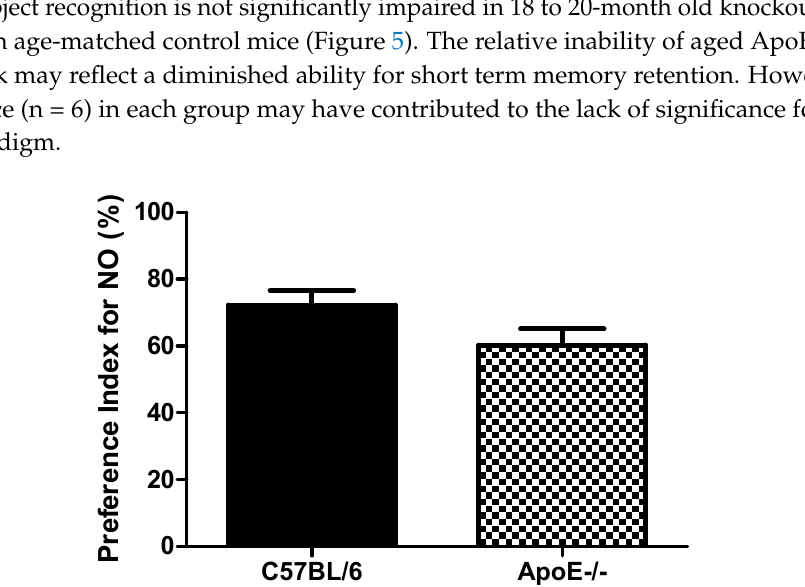
Figure 5. Preference Index in female C57Bl/6 and ApoE − / − mice (18 to 20 months) Values are expressed as means ± SEM (n = 6). No significant differences between groups (T(10) = 1.87, p = 0.091). Mann Whitney U Test.